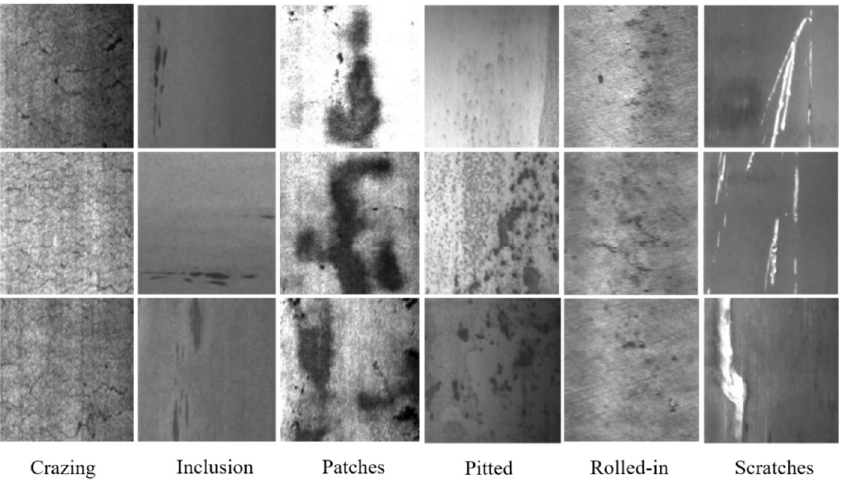
Figure 5. Sample images of six typical surface defects in NEU-CLS dataset.